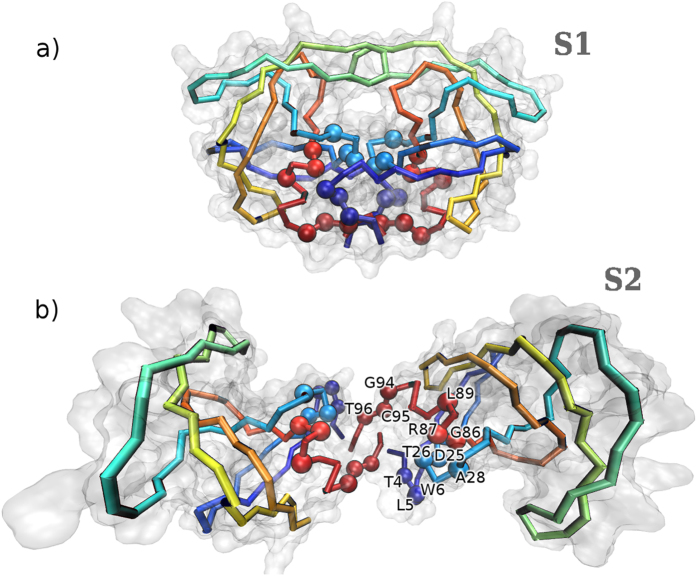
Protease residues (spheres) undergoing sizable chemical exchange on the μs-ms time scale in 1H and 15N nuclear spin transverse relaxation measurements in ref. 9, in (a) the crystallographic protease structure, and (b) the partially open structure S2C.